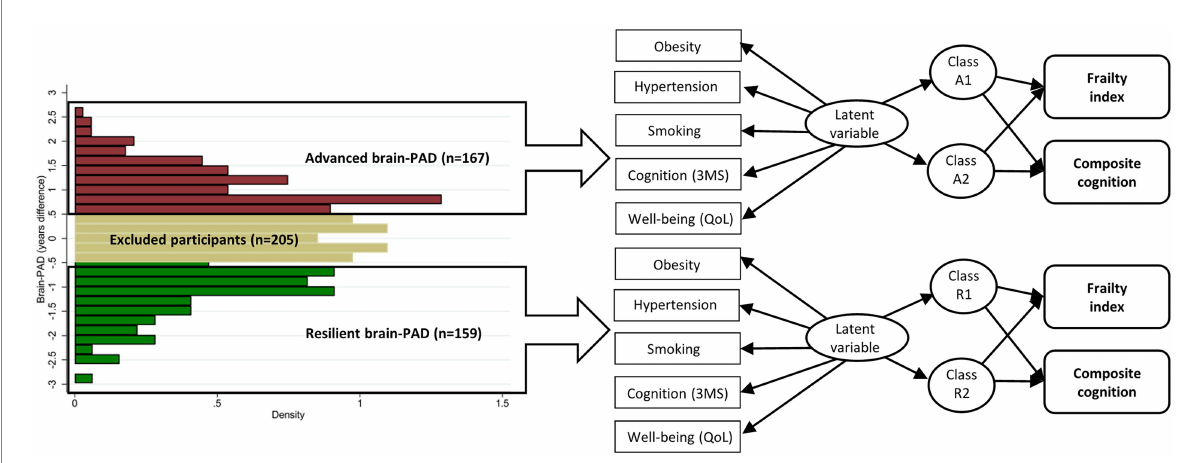
FIGURE 1 Overview of study methods, including identification of resilient and advanced brain agers, latent class analyses and the association between classes and the change in health outcomes over time. Abbreviations: 3MS = global cognitive function measured using Modified-Mini-Mental State (3MS) examination score (Teng and Chui, 1987); brain-PAD = brain-predicted age difference; QoL = quality of